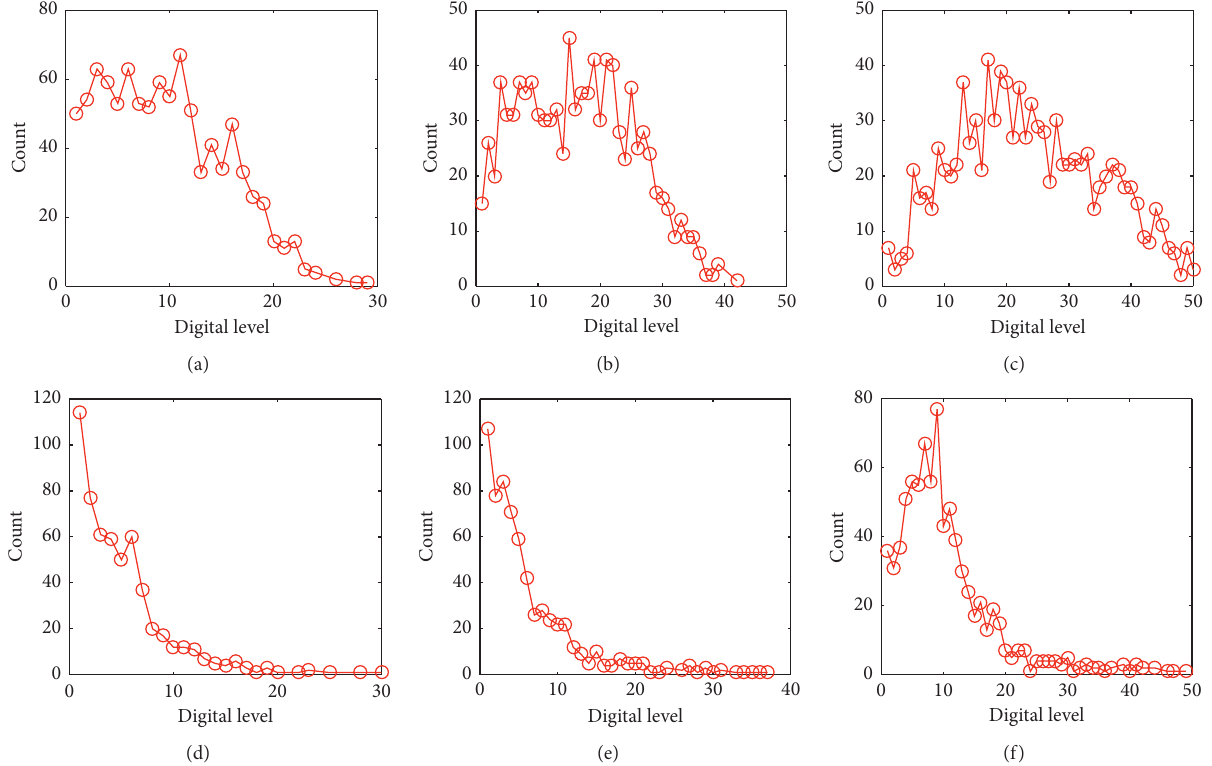
Figure 8: The digital levels of enterprises under different demand-side policies: (a) p 1 � 0.3, Cu � 1, Cb � 2; (b) p 1 � 0.5, Cu � 1, Cb � 2; (c) p 1 � 0.7, Cu � 1, Cb � 2; (d) p 1 � 0.3, Cu � 2, Cb � 4; (e) p 1 � 0.5, Cu � 2, Cb � 4; (f) p 1 � 0.7, Cu � 2, Cb �